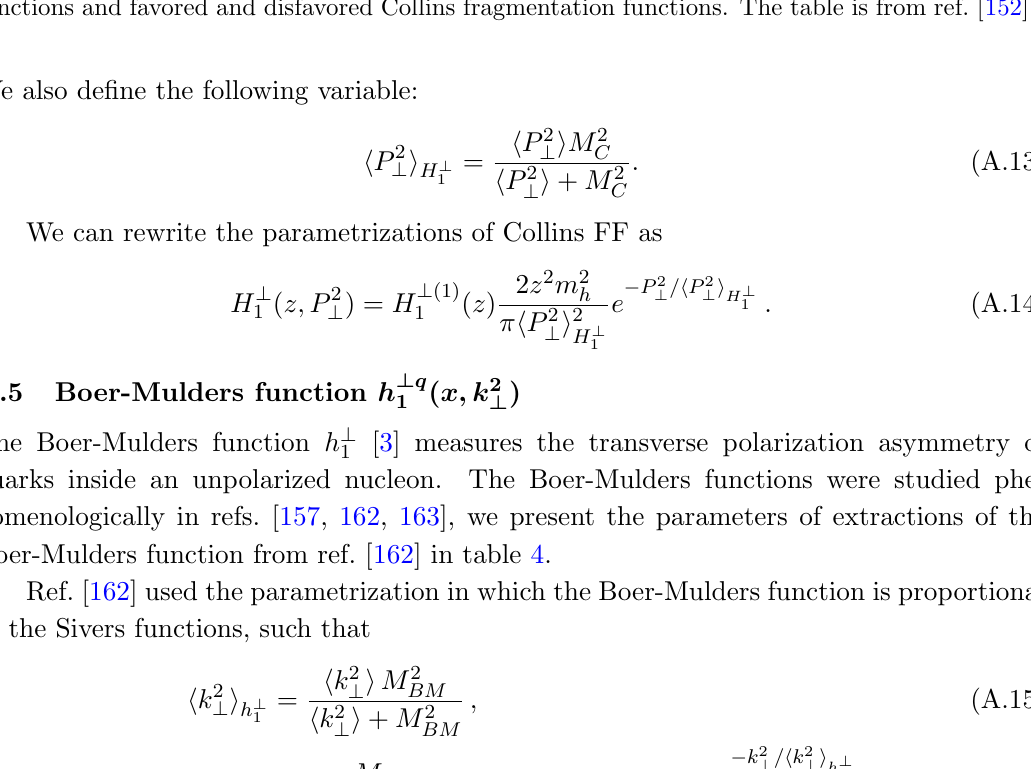
Table 3. Best values of the 9 free parameters (cid:12)xing the u and d quark transversity distribution functions and favored and disfavored Collins fragmentation functions. The table is from ref.